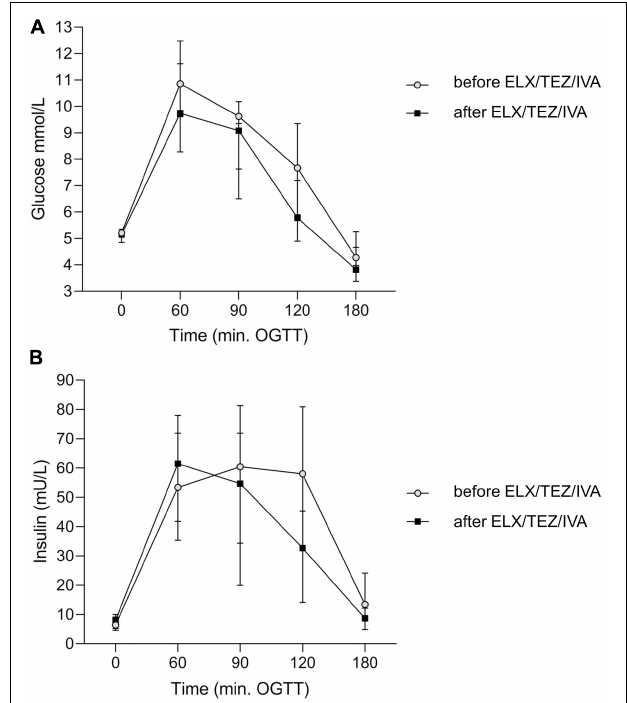
FIGURE 3 | Time course of plasma glucose (A) and insulin (B) levels before and after the start of ELX/TEZ/IVA treatment at different time points of the OGTT in people with cystic fibrosis. After starting ELX/TEZ/IVA treatment (A) , plasma glucose levels (in mmol/L) were lower at 60, 90, and 120 min of OGTT (all p < 0.05), but no difference was found for fasting glucose and glucose levels at 180 min of OGTT. (B) Plasma insulin levels (in mU/L) were lower at 120 min ( p = 0.04) and 180 min ( p = 0.006), whereas no differences were found for fasting and early insulin secretion. OGTT, oral glucose tolerance